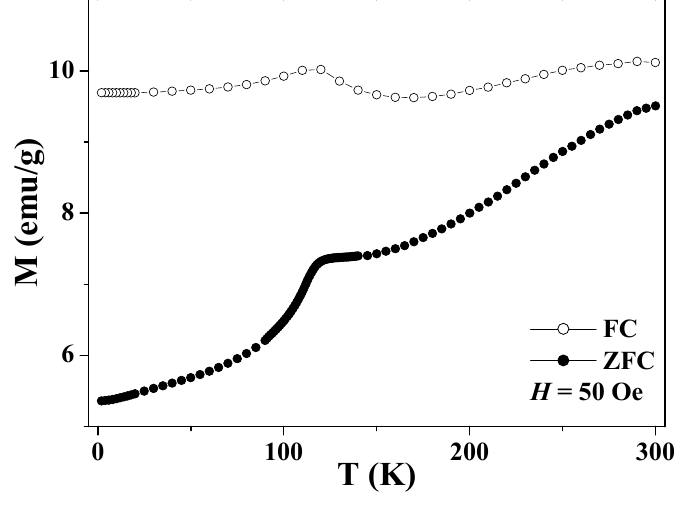
Figure 7. Temperature dependence of the zero-field cooled (ZFC) and field-cooled (FC) magnetizations of the magnetite hollow